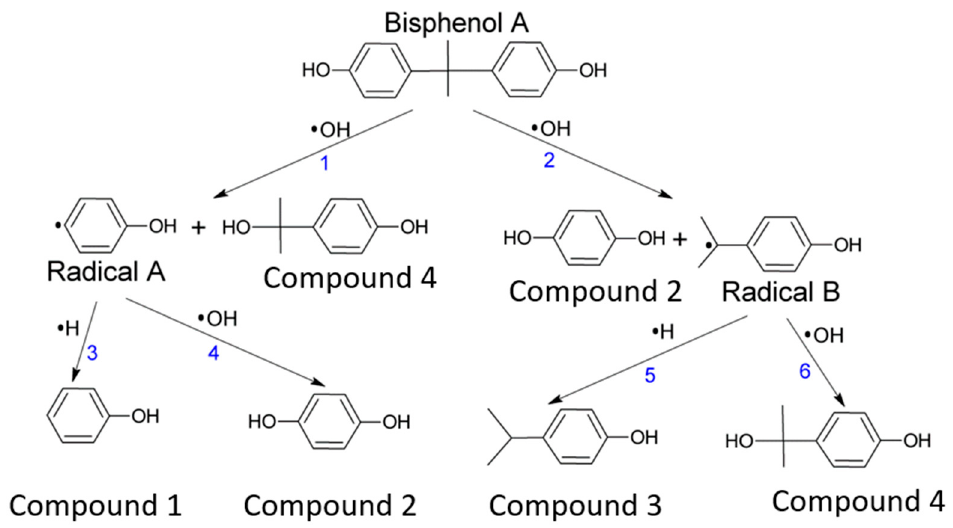
Figure 2. BPA degradation scheme in the presence of OH radicals adopted from Katsumata et al. [21]. Phenol (compound 1 ), hydroquinone (compound 2 ), 4-isopropylphenol (compound 3 ), 4-(2- hydroxy)isopropylphenol (compound 4 ).